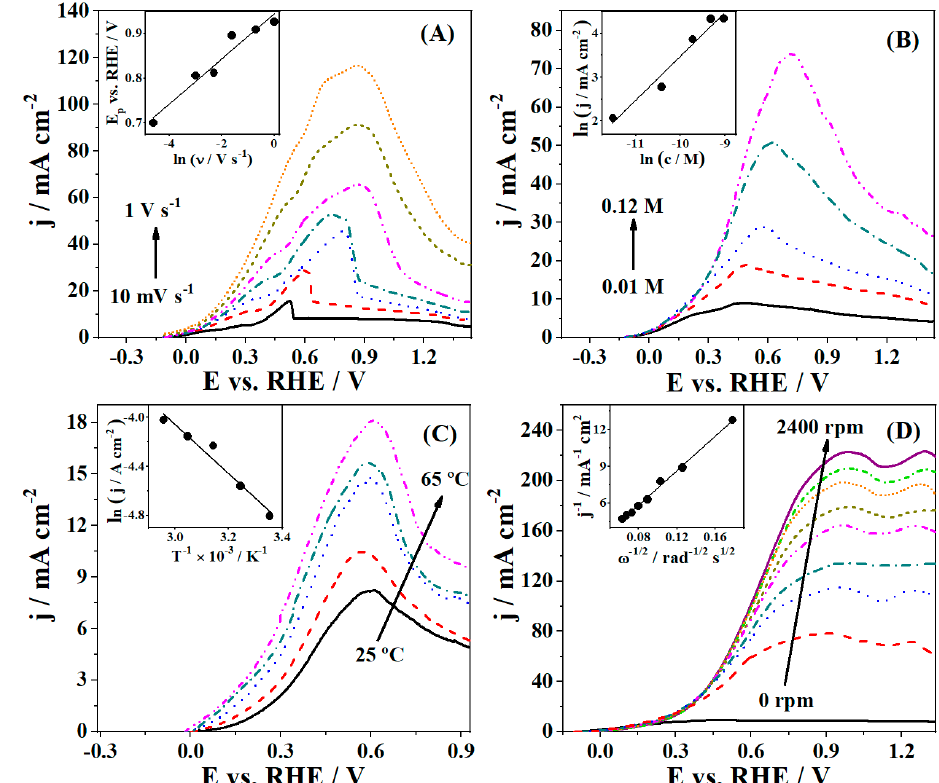
Figure 7. CVs of PdAuNi/C SBIPA at ( A ) different scan rates, ν , and the derived E p vs. ln ν plots (inset), ( B ) different NaBH 4 concentrations and the derived ln j vs. ln c plots (inset), ( C ) different temperatures and the derived Arrhenius plots (inset), and ( D ) LSVs of PdAuNi/C SBIPA at 10 mV s − 1 and different rotation rates and the derived Koutecky–Levich plot (inset). The electrolyte solution used was 0.03 M NaBH 4 + 2 M NaOH, polarization rate was 50 mV s − 1 , with room temperature (25 ◦ C), unless otherwise